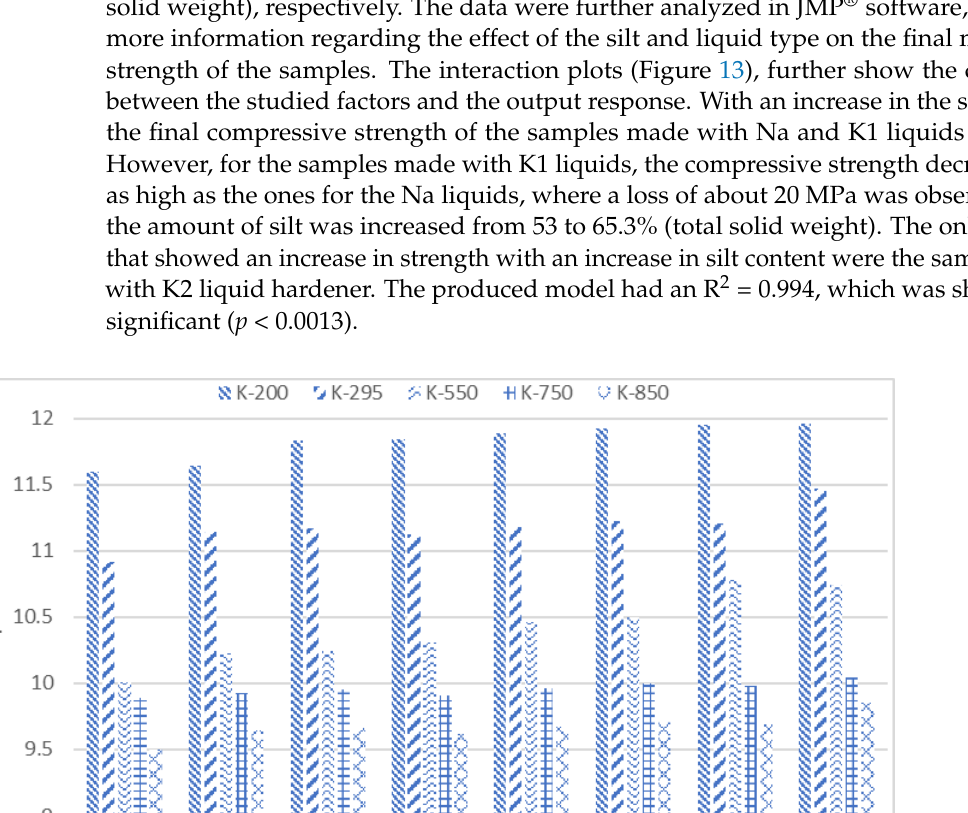
Figure 11. Contour Plot for K1-based geopolymer cement.